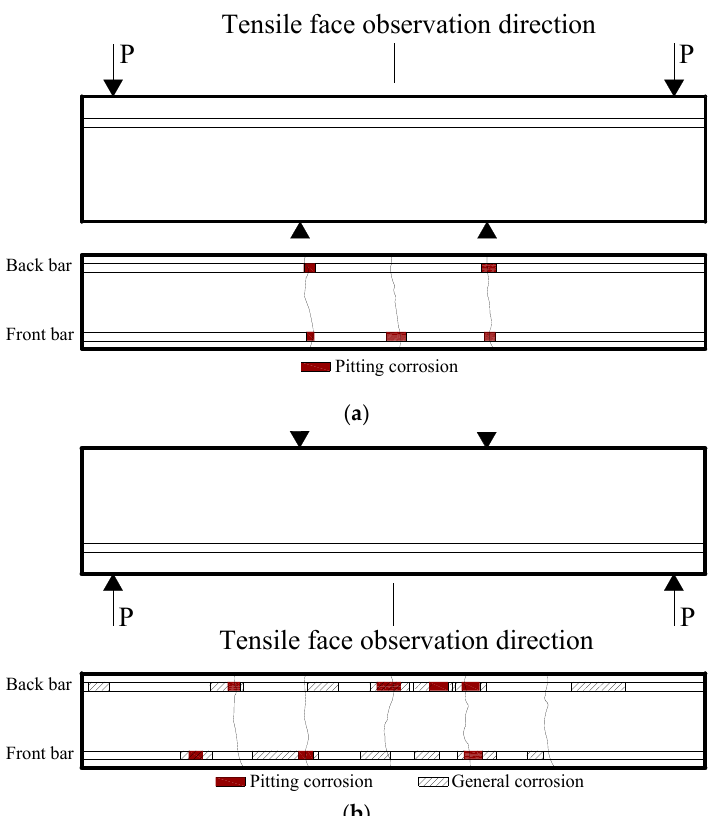
Figure 12. Corrosion map of tensile steel bars in beams. ( a ) B-01-2 (182 days; ( b ) B-02-3 (364 days)